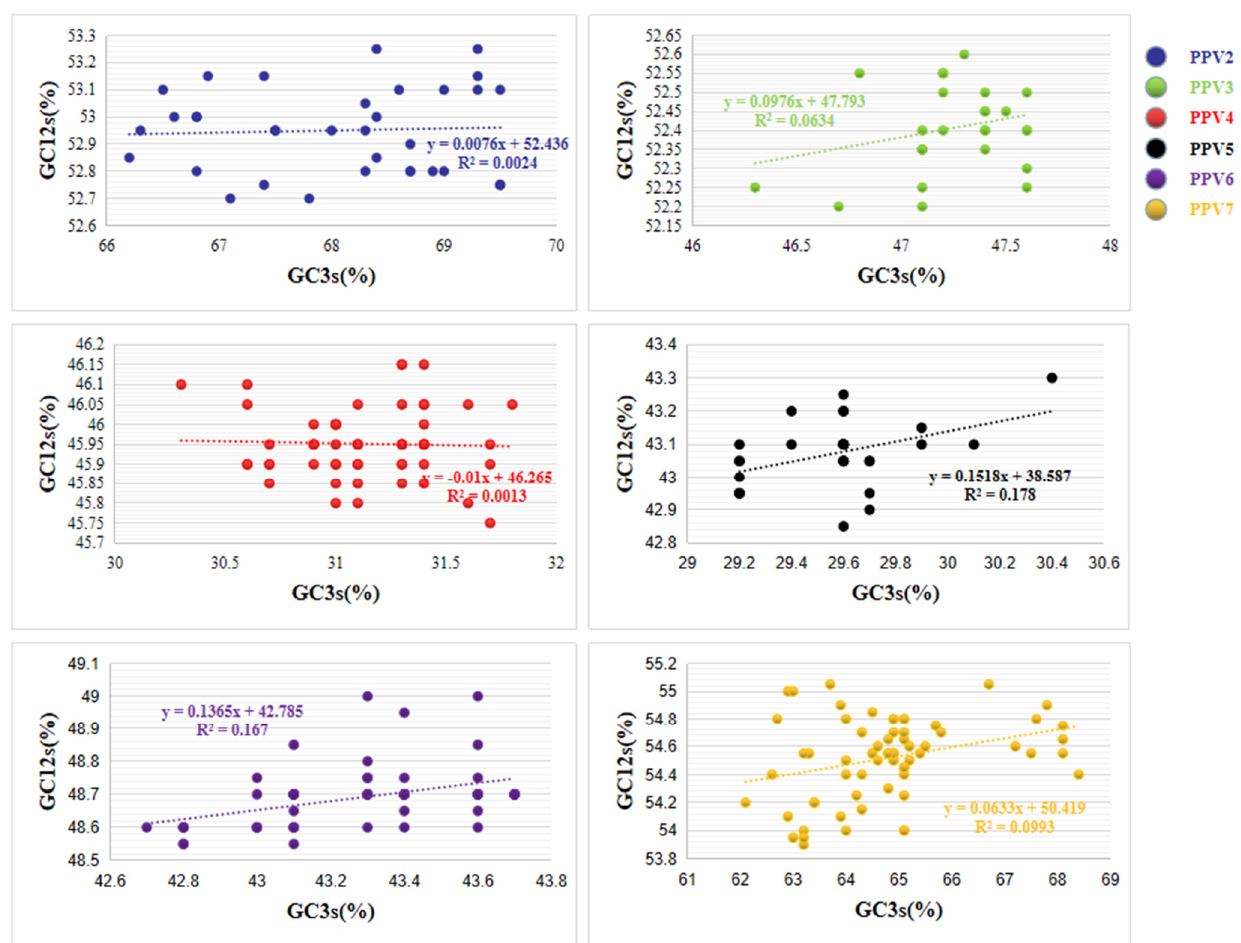
Figure 5. Neutrality plot of each sub-type of PPV.